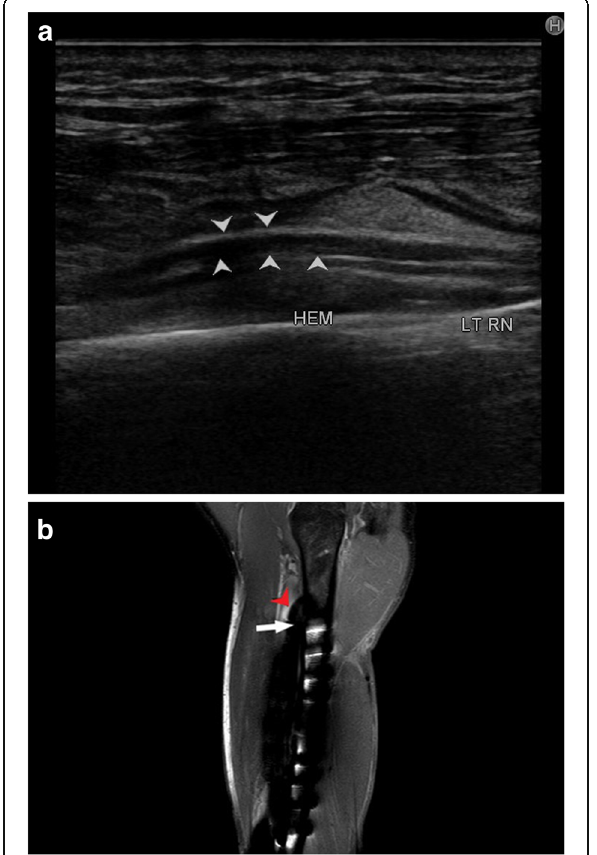
Fig. 9 a Long axis view of the left radial nerve (arrowhead) showing displacement by local hematoma (HEM). b Coronal PDFS sequence showing hyperintense radial nerve (black arrowhead) with underlying hematoma in acute stage, as seen in ( a ) is demonstrated. Hyperintense screws of the medullary nail implanted for fixation of the fracture of shaft of humerus can also be seen